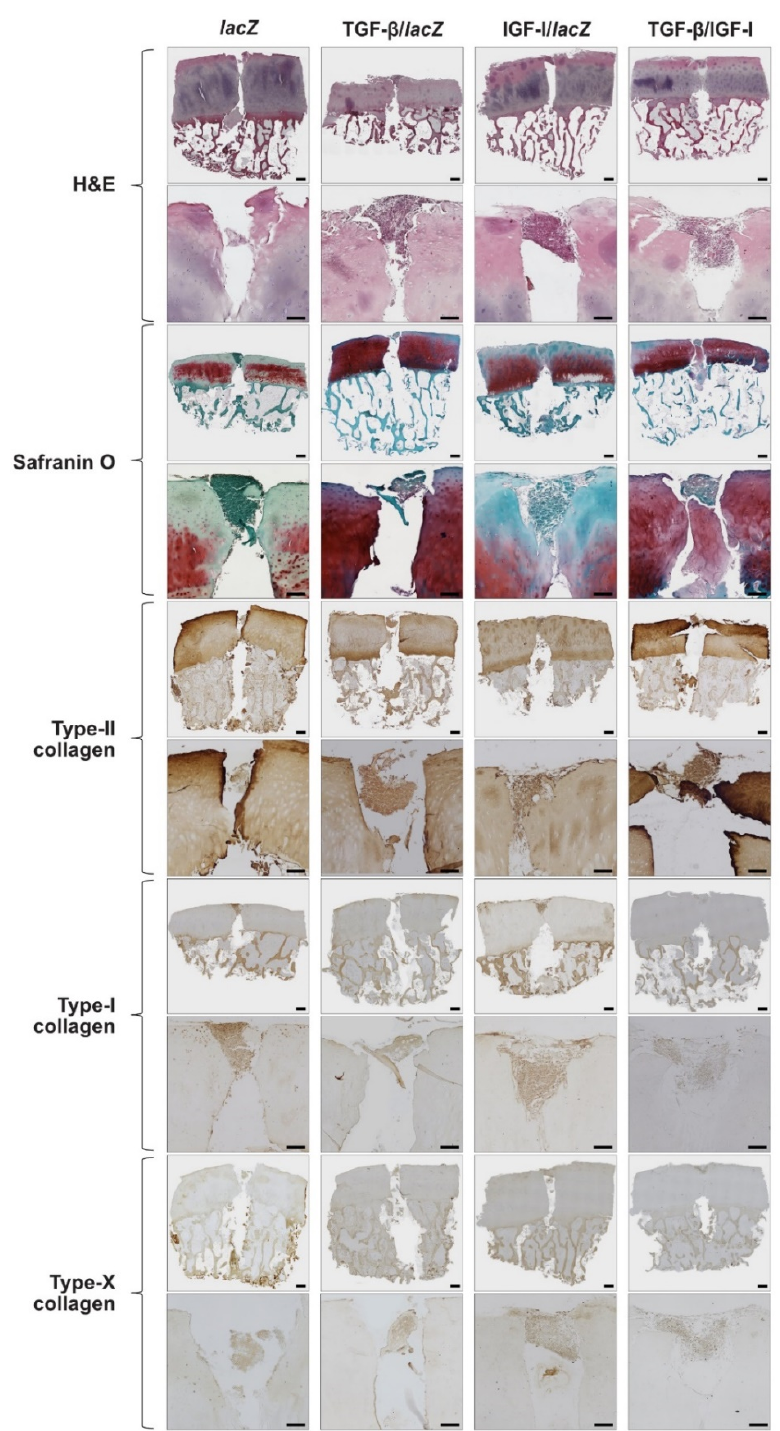
Figure 3. Biological, chondrogenic, osteogenic, and hypertrophic differentiation activities in human OCDs following implantation of rAAV-transduced hMSC aggregates. Aggregates were cotransduced with rAAV TGF-β/IGF-I, TGF-β/ lac Z, IGF-I/ lac Z or transduced with rAAV lac Z and implanted in human OCDs as described in Figures 1 and 2 and in the Materials and Methods. Samples were processed after 21 days to evaluate cellularity (H&E staining) and the deposition of matrix proteoglycans (safranin O staining), type-II/-I/-X collagen (immunohistochemistry) (for each type of staining: top panel at magnification × 10 with scale bars of 500 µm, bottom panels including the region immediately adjacent to the implanted pellets at magnification ×20 with scale bars of 200 µm; representative data).